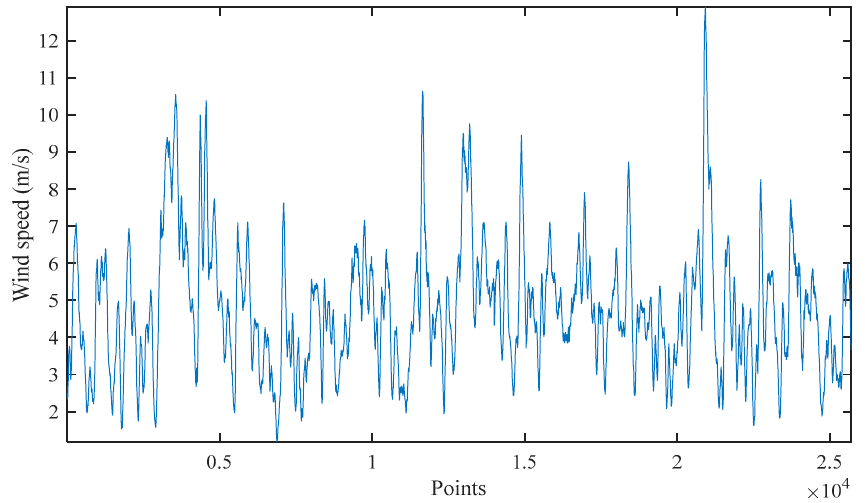
Figure 6. Actual wind speed of the wind turbine (Case 1).